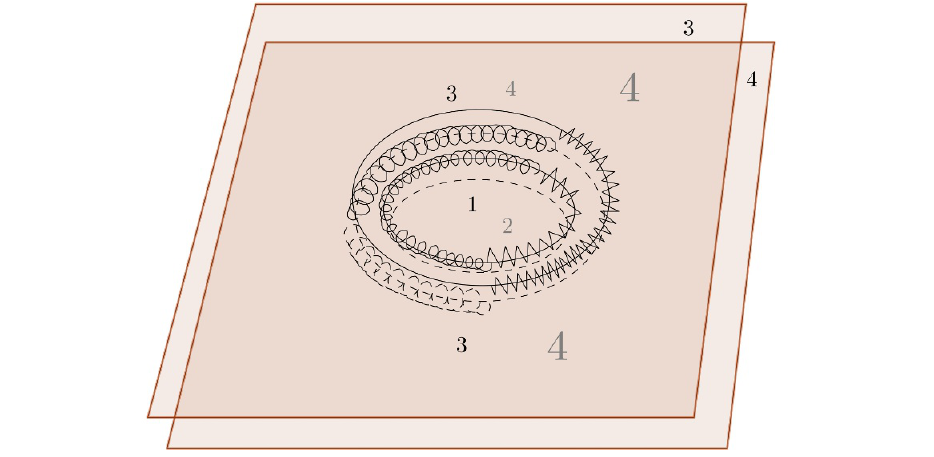
Figure 25 . On this (cid:12)gure we show in a similar way the edge-decorations on the disc 1 marked and and the corresponding pieces of the edges of the complements 3 and